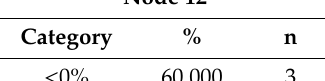
Figure 7. The classification results for N03 (The Wall Street Journal) at Node 9 and Node 10.